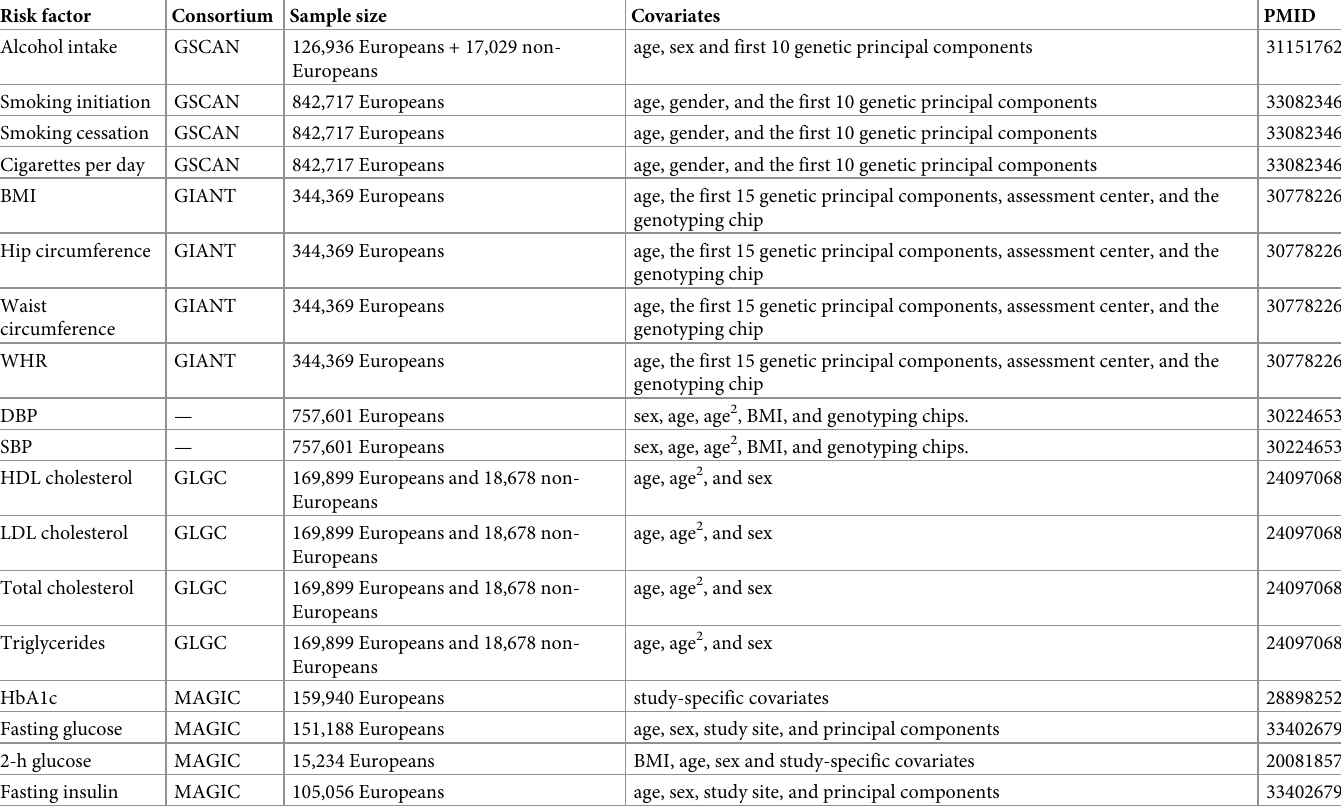
Table 1. A brief description of GWAS summary statistics for modifiable risk